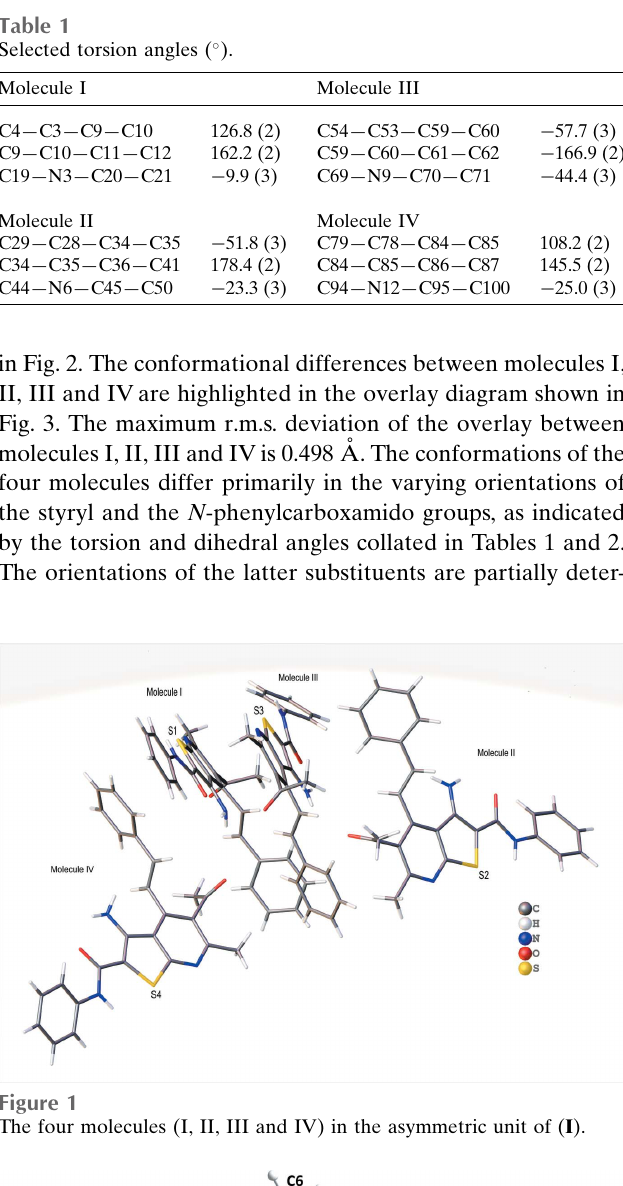
Table 2 Dihedral angles ( (cid:4) ).